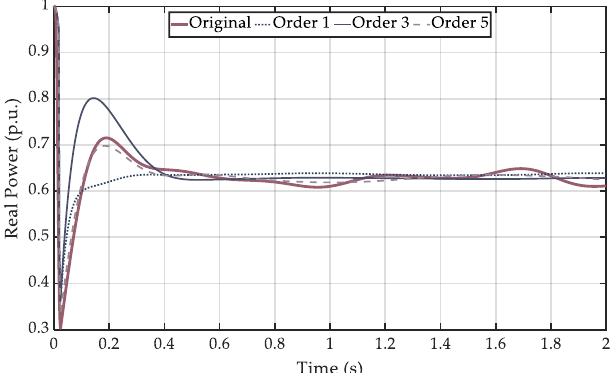
Figure 13. Modelling of real power. Estimations provided by the TFNL using different model orders.